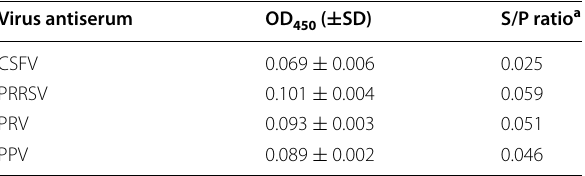
a S/P ratio cutoffs: positive